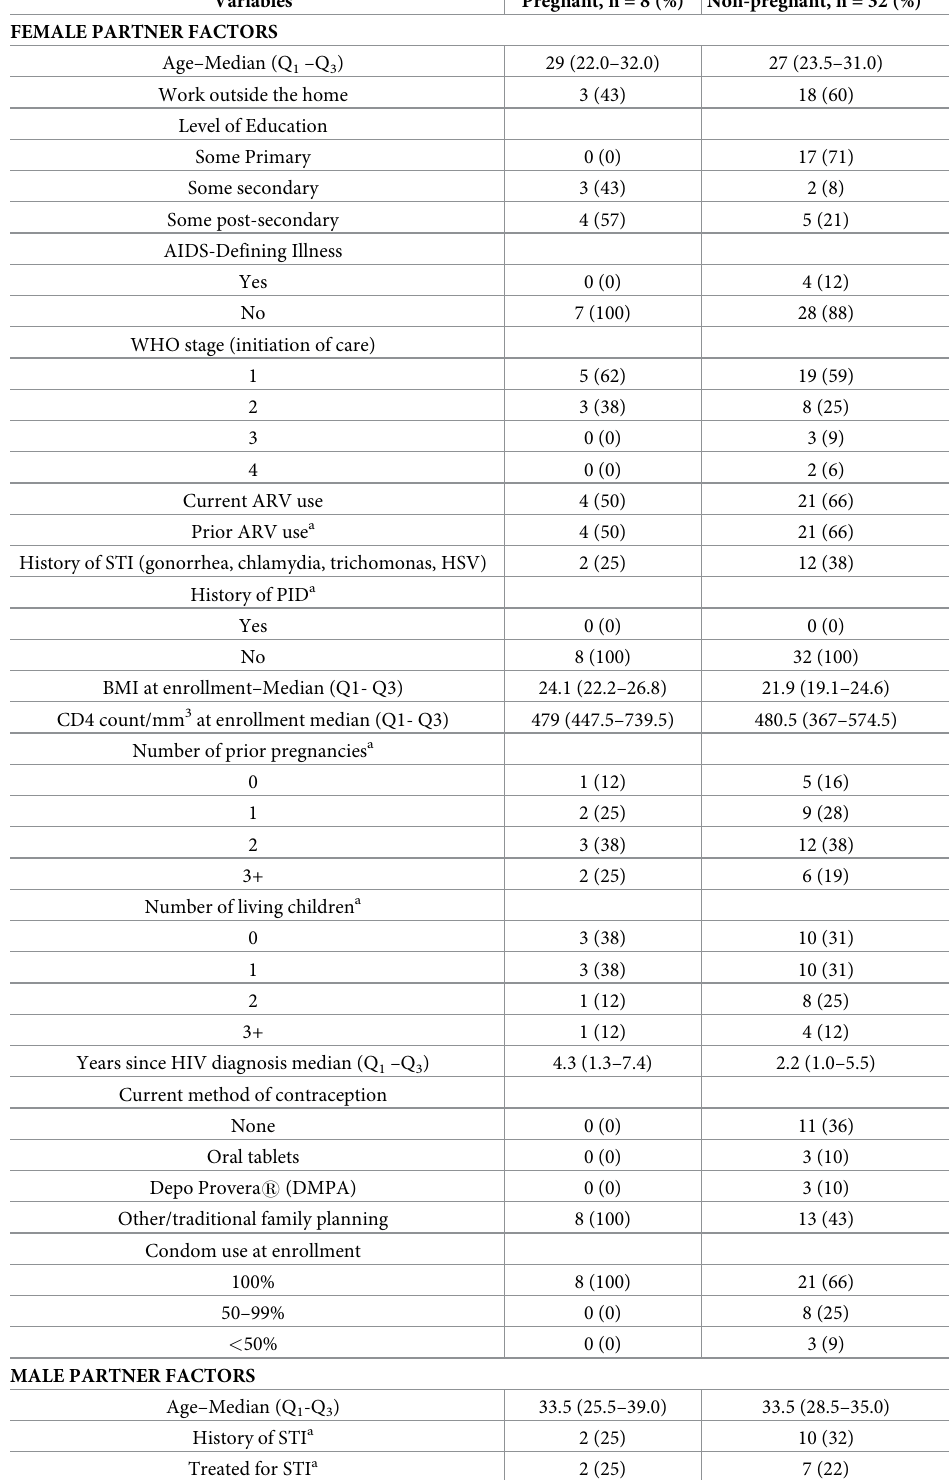
Table 1. Incidence and predictors of pregnancy at enrollment (n =